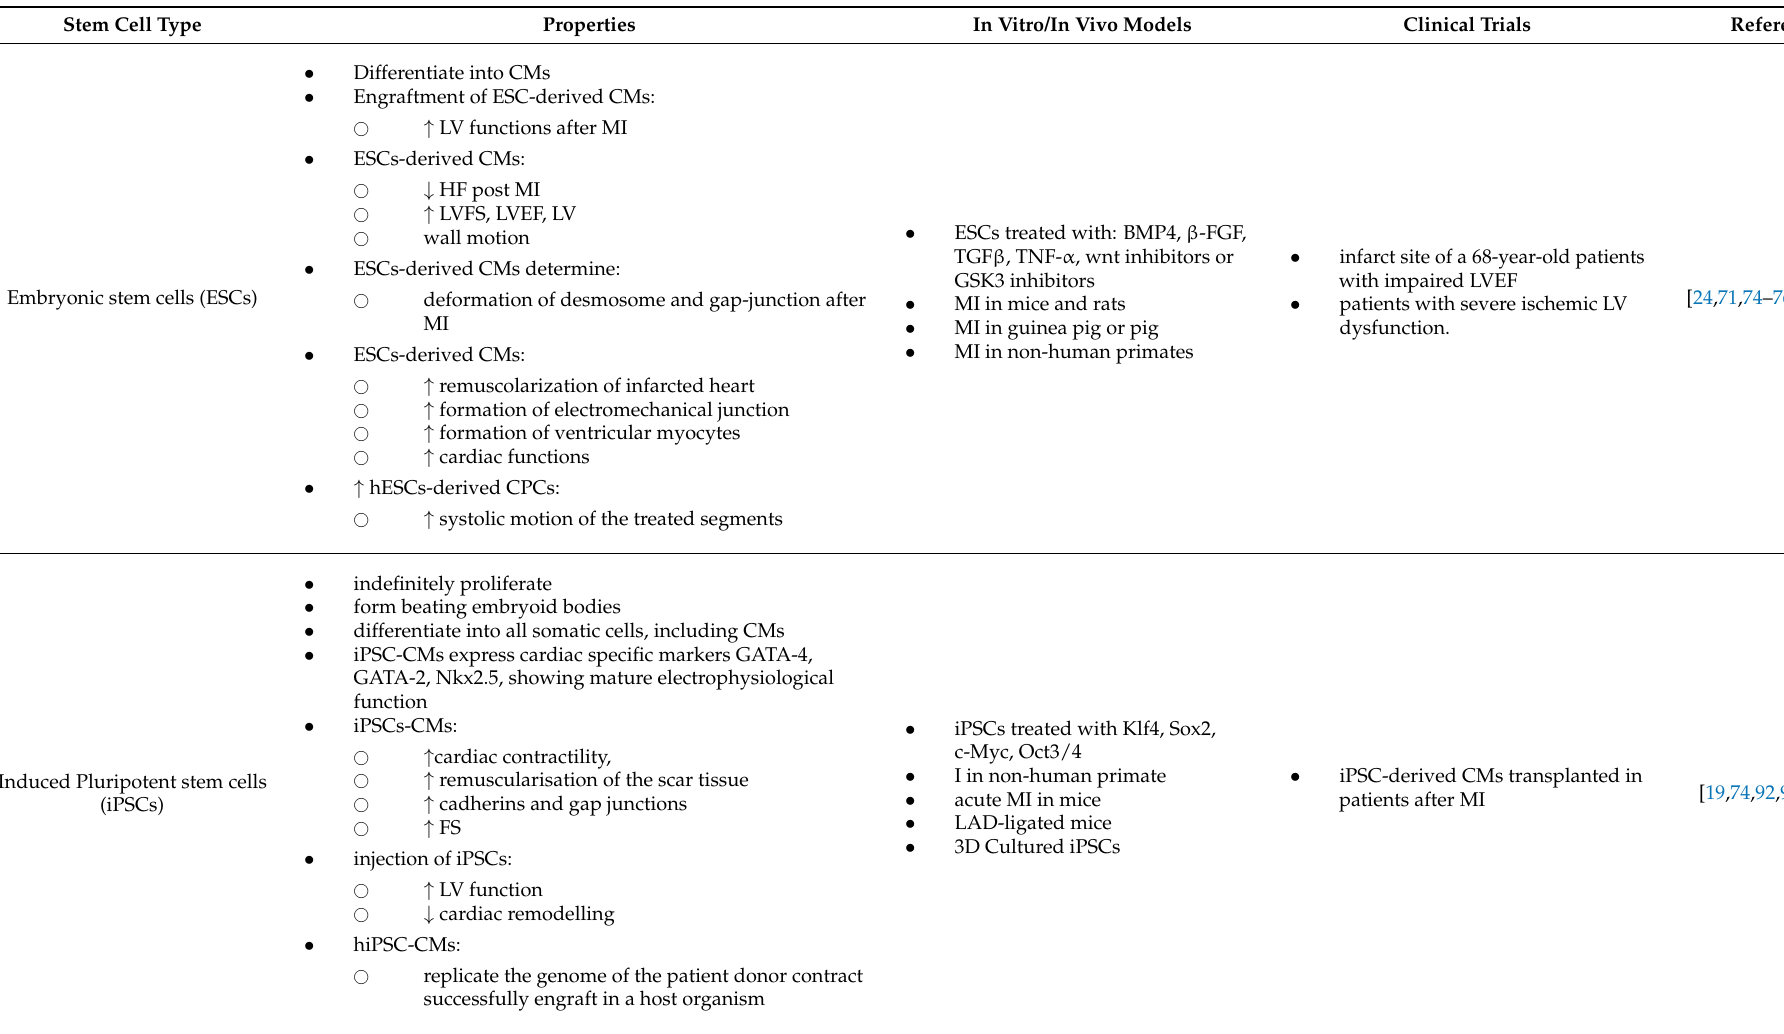
Table 1. Stem cell properties in cardiac